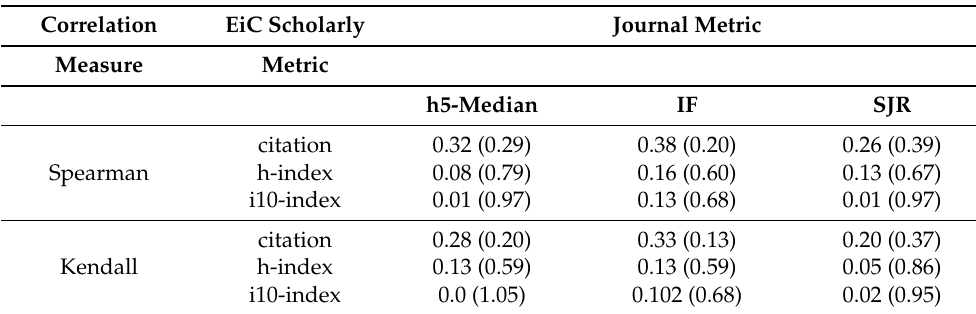
Table 3. Correlation scores between various pairs of the EiC and journal-level metrics in BCB journals ( p -values are shown inside parentheses).